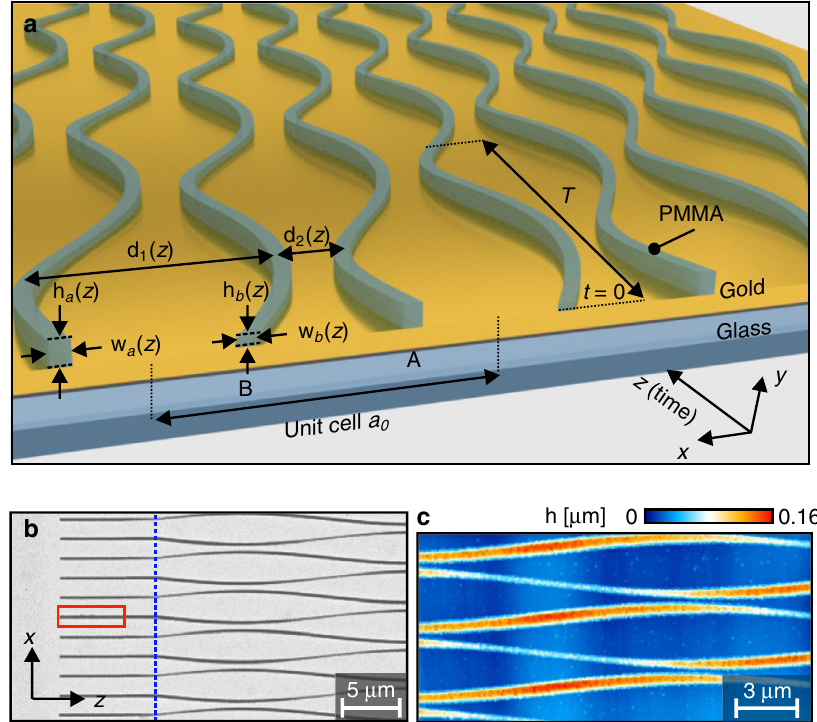
Fig. 4 Plasmonic implementation of the NH RM model. a Sketch of the plasmonic implementation of the NH RM model. b Scanning electron micrograph of a typical sample corresponding to J 0 = 0.144 μ m − 1 , Ω = 1.45 J 0 , u 0 = 1.1 J 0 , γ 0 = 0.8 J 0 . The red dotted box highlights the grating coupler deposited onto the input waveguide A. c AFM scan of the same sample as shown in b